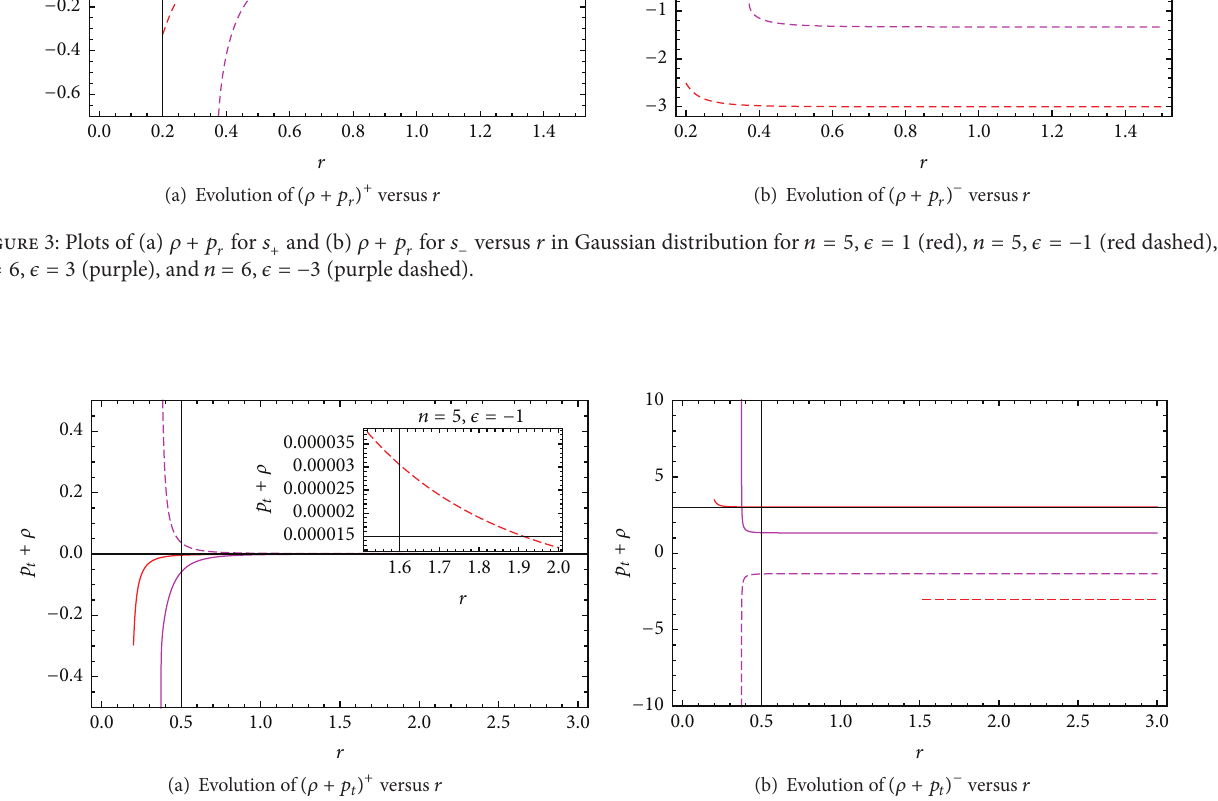
Figure 4: Plots of (a) 𝜌 + 𝑝 𝑡 for 𝑠 + and (b) 𝜌 + 𝑝 𝑡 for 𝑠 − versus 𝑟 for in Gaussian distribution 𝑛 = 5 , 𝜖 = 1 (red), 𝑛 = 5 , 𝜖 = −1 (red dashed), 𝑛 = 6 , 𝜖 = 3 (purple), and 𝑛 = 6 , 𝜖 = −3 (purple dashed).